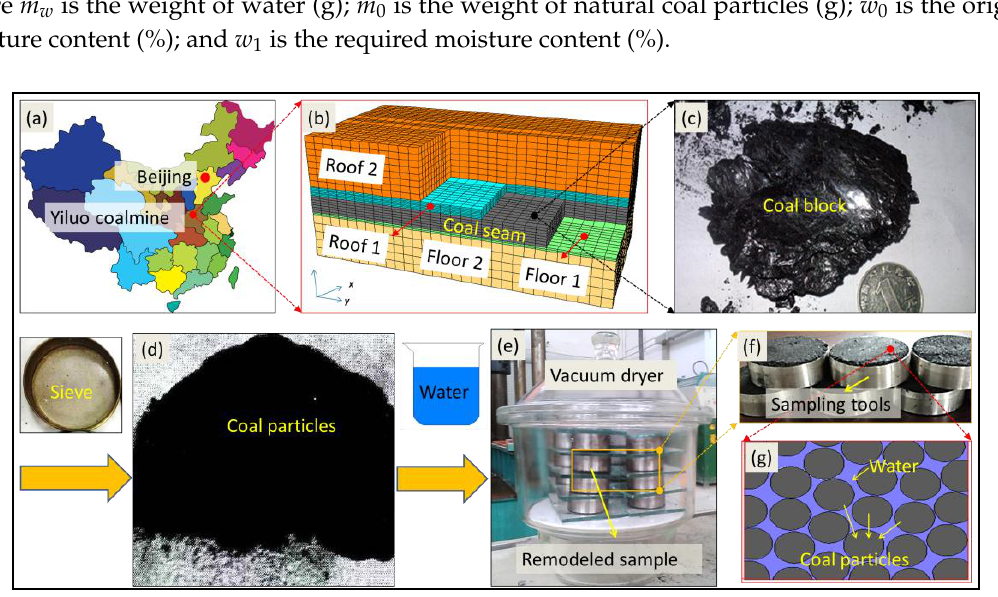
Figure 1. Remodelling processes. ( a ) Location of the Yiluo coalmine; ( b ) Three-dimensional schematic of a coal seam sandwiched between rock strata; ( c ) A coal block taken from the in situ Yiluo coal mine; ( d ) Coal particles; ( e ) Remodelled specimens in a vacuum dryer. ( f ) Remodelled specimens ( φ 61.8 mm × 40 mm) in sampling tools; ( g ) Schematic of water and coal particles. Table 1. Proximate analysis of coal. W: water content; A: ash yield; V: volatile matter; FC: fixed carbon; S: total sulfur; CV: calorific value.